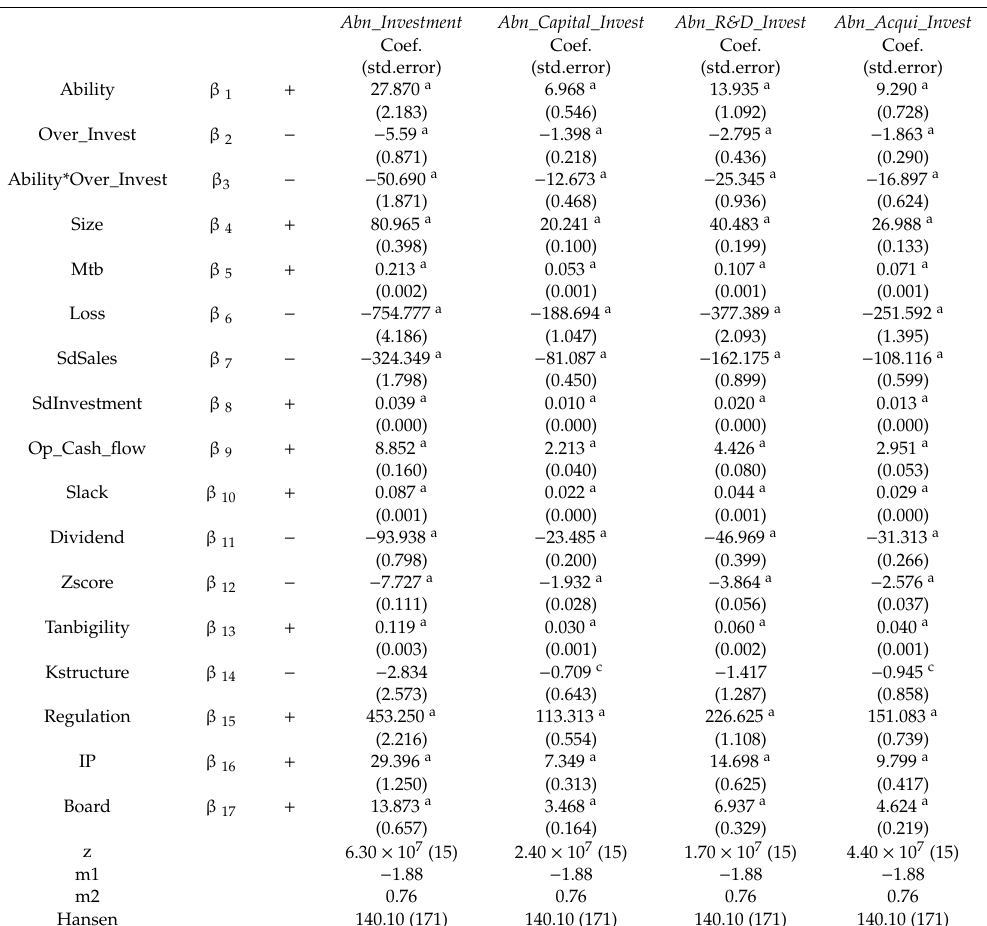
Panel B. Results for Model [2]: Association between Managerial Ability and Abnormal Investments Conditioning Firms’ Tendencies towards